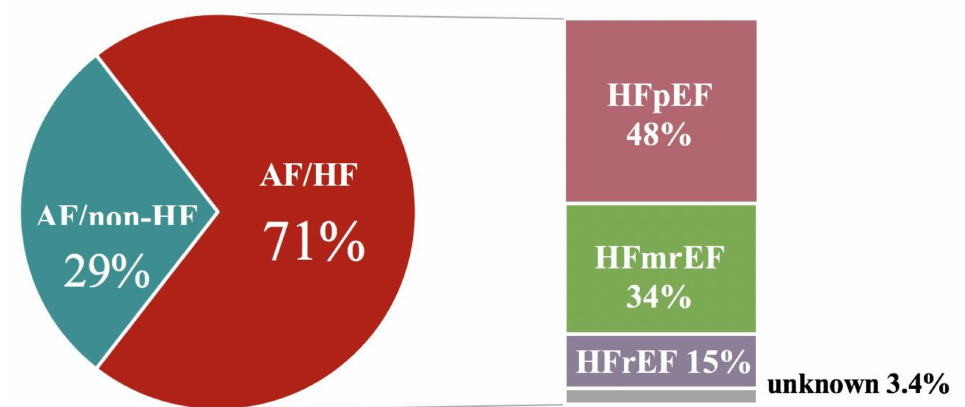
Figure 1. Frequency of heart failure and its subtypes in hospitalized atrial fibrillation patients. Abbreviations: AF, atrial fibrillation; HF, heart failure; HFmEF, heart failure with mild-range ejection fraction; HFpEF, heart failure with preserved ejection fraction; HFrEF, heart failure with reduced ejection